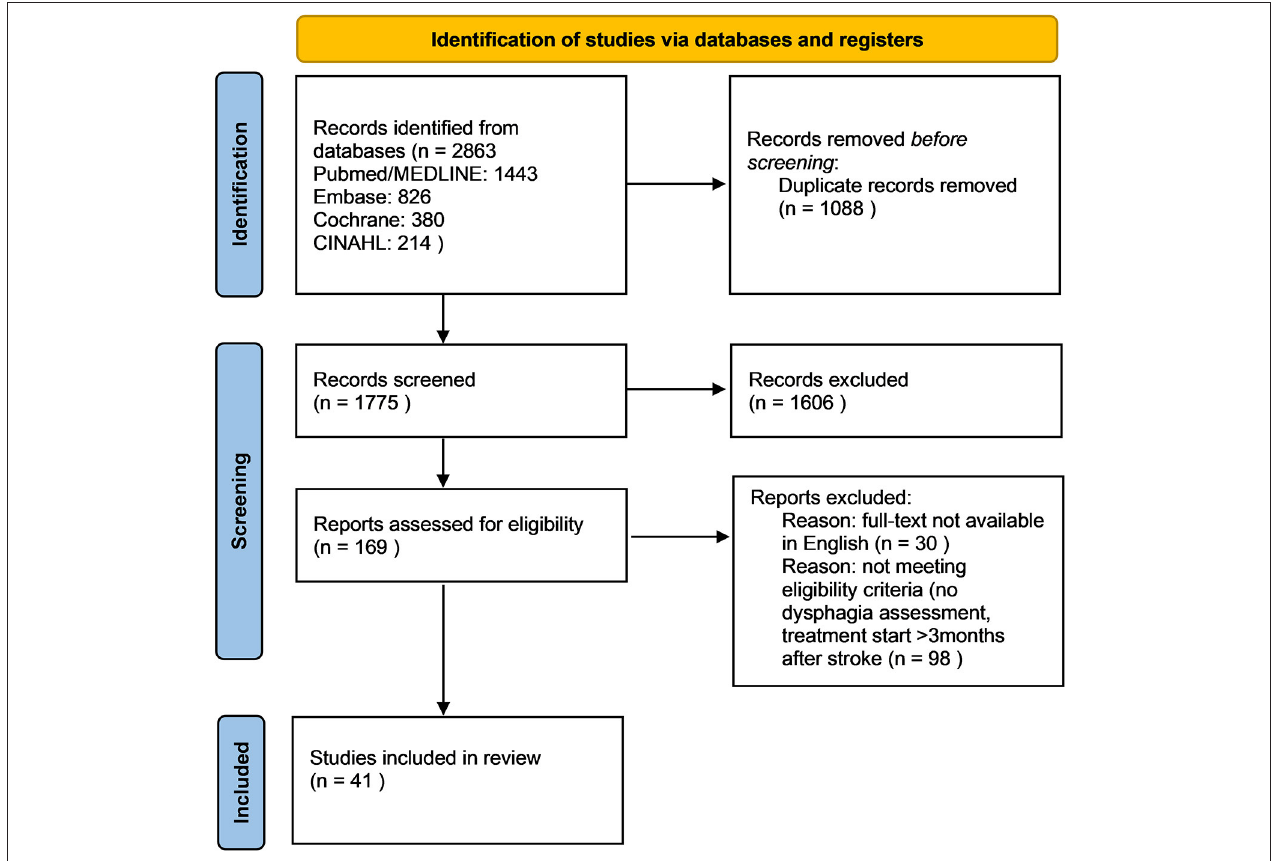
FIGURE 1 | Flow diagram on literature